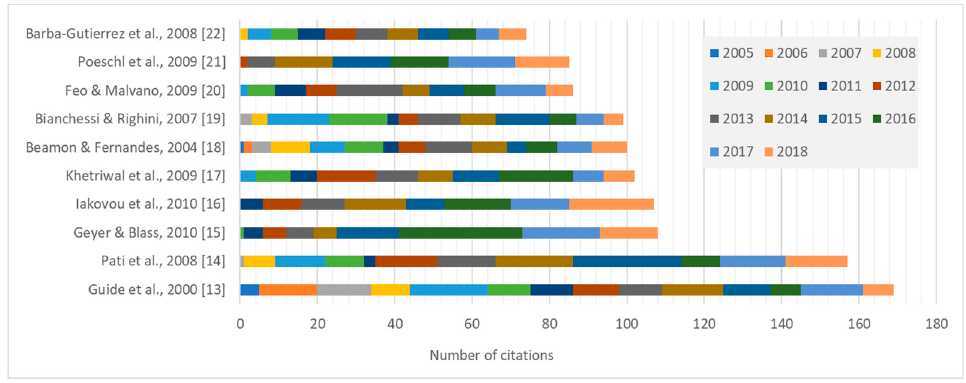
Figure 5. The 10 most cited articles based on search in Web of Science [13–22].